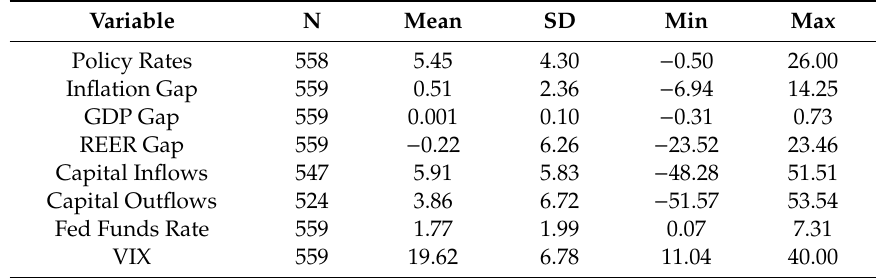
Table A2. Summary Statistics.